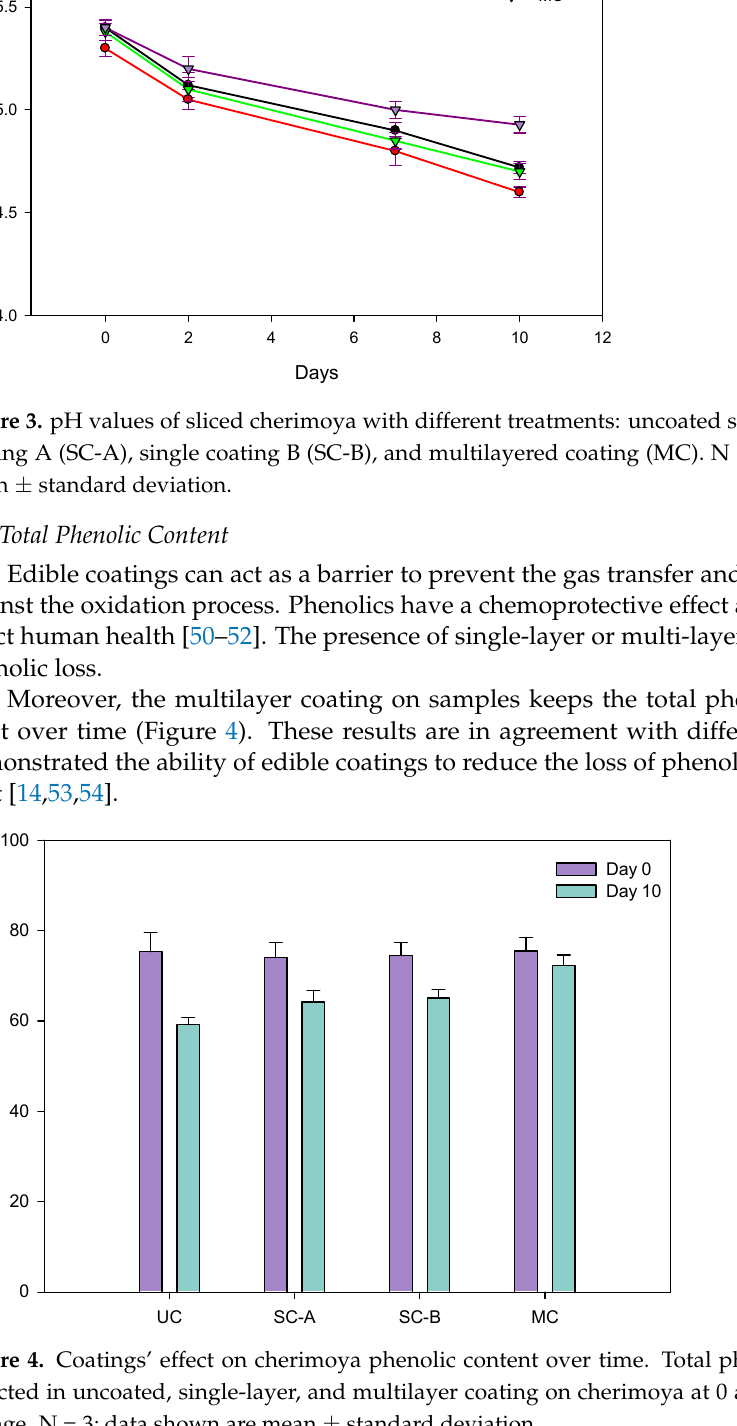
Figure 2. Weight loss of sliced cherimoya with different treatments: uncoated samples (UC), single coating A (SC-A), single coating B (SC-B), and multilayered coating (MC). N = 3; data shown are mean ± standard deviation.